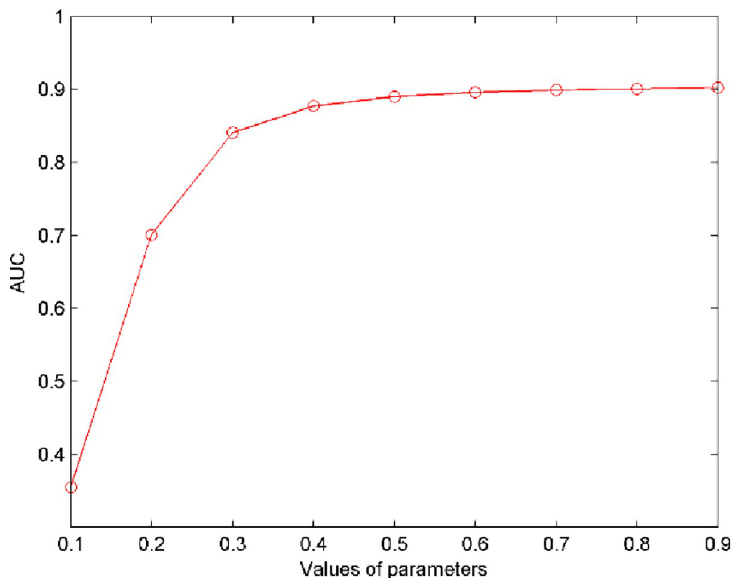
Fig 2. Influence of parameter variations on prediction